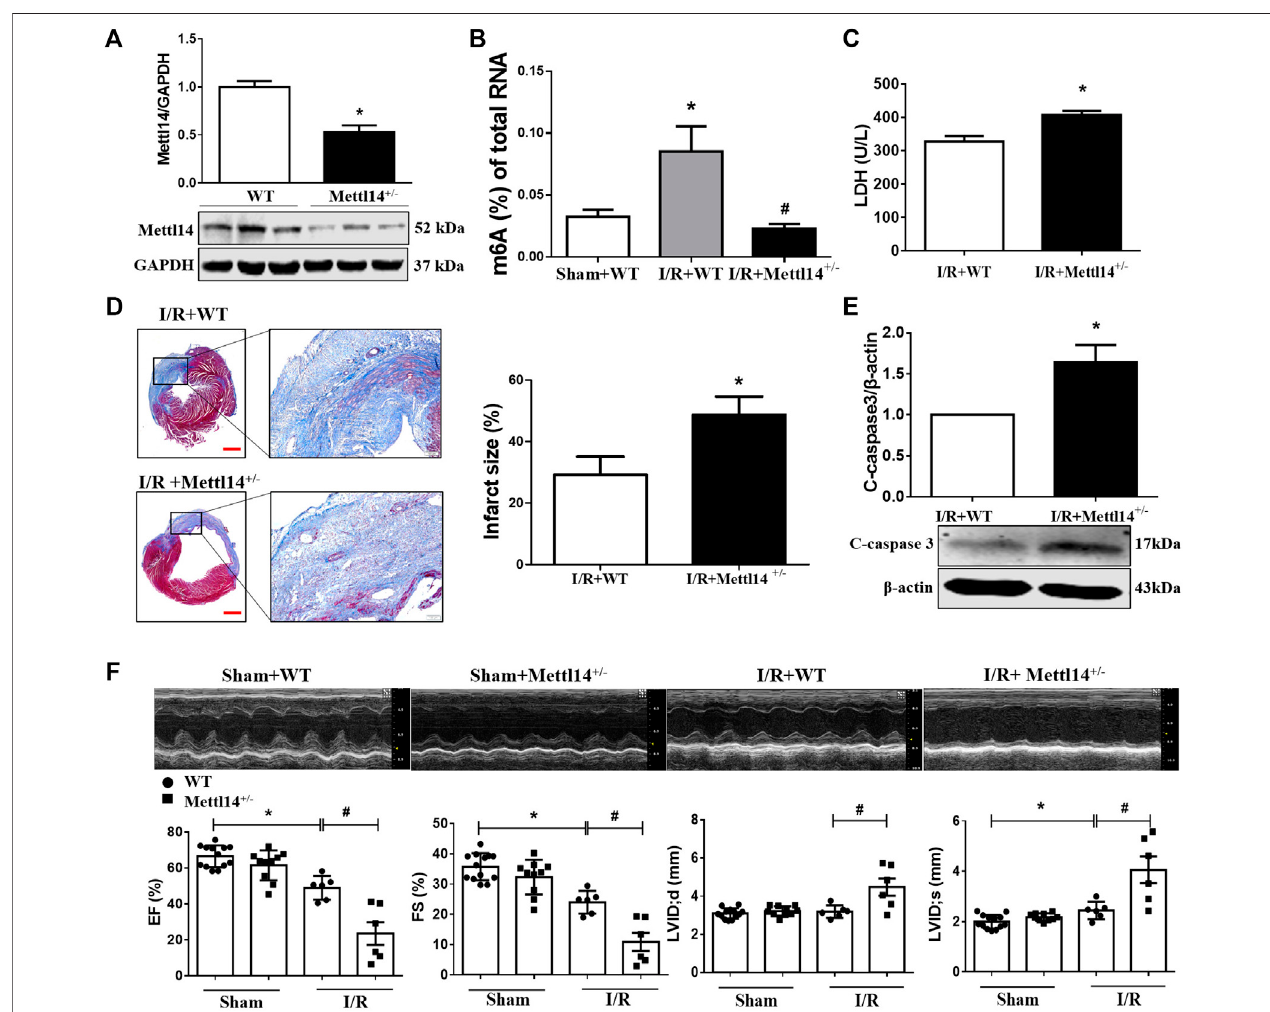
FIGURE 2 | De fi ciency of Mettl14 aggravates cardiac injury and dysfunction in I/R mice. (A) Veri fi cation of Mettl14 knockdown ef fi ciency. The knockdown mice were subjected to sham or I/R operation for 7 days. Mettl14 protein levels in Mettl14 +/ − mice were analyzed by Western blotting. n (cid:2) 6 mice per group. * p < 0.05 versus WT. (B) Enzyme-linkedimmunosorbentassay(ELISA) detectsthelevelofm6Amodi fi cationoftotalRNA.Sham+WT n (cid:2) 5,I/R+WT n (cid:2) 4,I/R+Mettl14 +/ − n (cid:2) 4.* p < 0.05 versus sham+WT. # p < 0.05 versus I/R+WT. (C) Plasma was obtained from mice at 4 weeks of I/R. Plasma LDH activity was analyzed by using a lactate dehydrogenase assay kit. n (cid:2) 3 mice per group. * p < 0.05 versus I/R+WT. (D) Infarct scar of I/R-7 day; sham-operated mice was treated by Masson ’ s trichrome, scale bar (cid:2) 500 µm (left), scar bar (cid:2) 100 µm (right). The midline length measurement was used to determine infarct scar. n (cid:2) 5 mice per group. * p < 0.05 versus I/R+WT. (E) The cleaved caspase-3 expression was analyzed by Western blotting. n (cid:2) 4 mice per group. * p < 0.05 versus I/R+WT. (F) Representative images of echocardiographs and statistics ofejectionfraction (EF),fractionalshortening (FS),leftventricularinternal dimension atsystole (LVIDs),and leftventricular internaldimension atend-diastole (LVIDd).Sham+WT n (cid:2) 13,sham+Mettl14 +/ − n (cid:2) 10,I/R+WT n (cid:2) 6,I/R+Mettl14 +/ − n (cid:2) 6.* p < 0.05versussham+WT. # p < 0.05versusI/R+WT.Dataarerepresented as mean ±